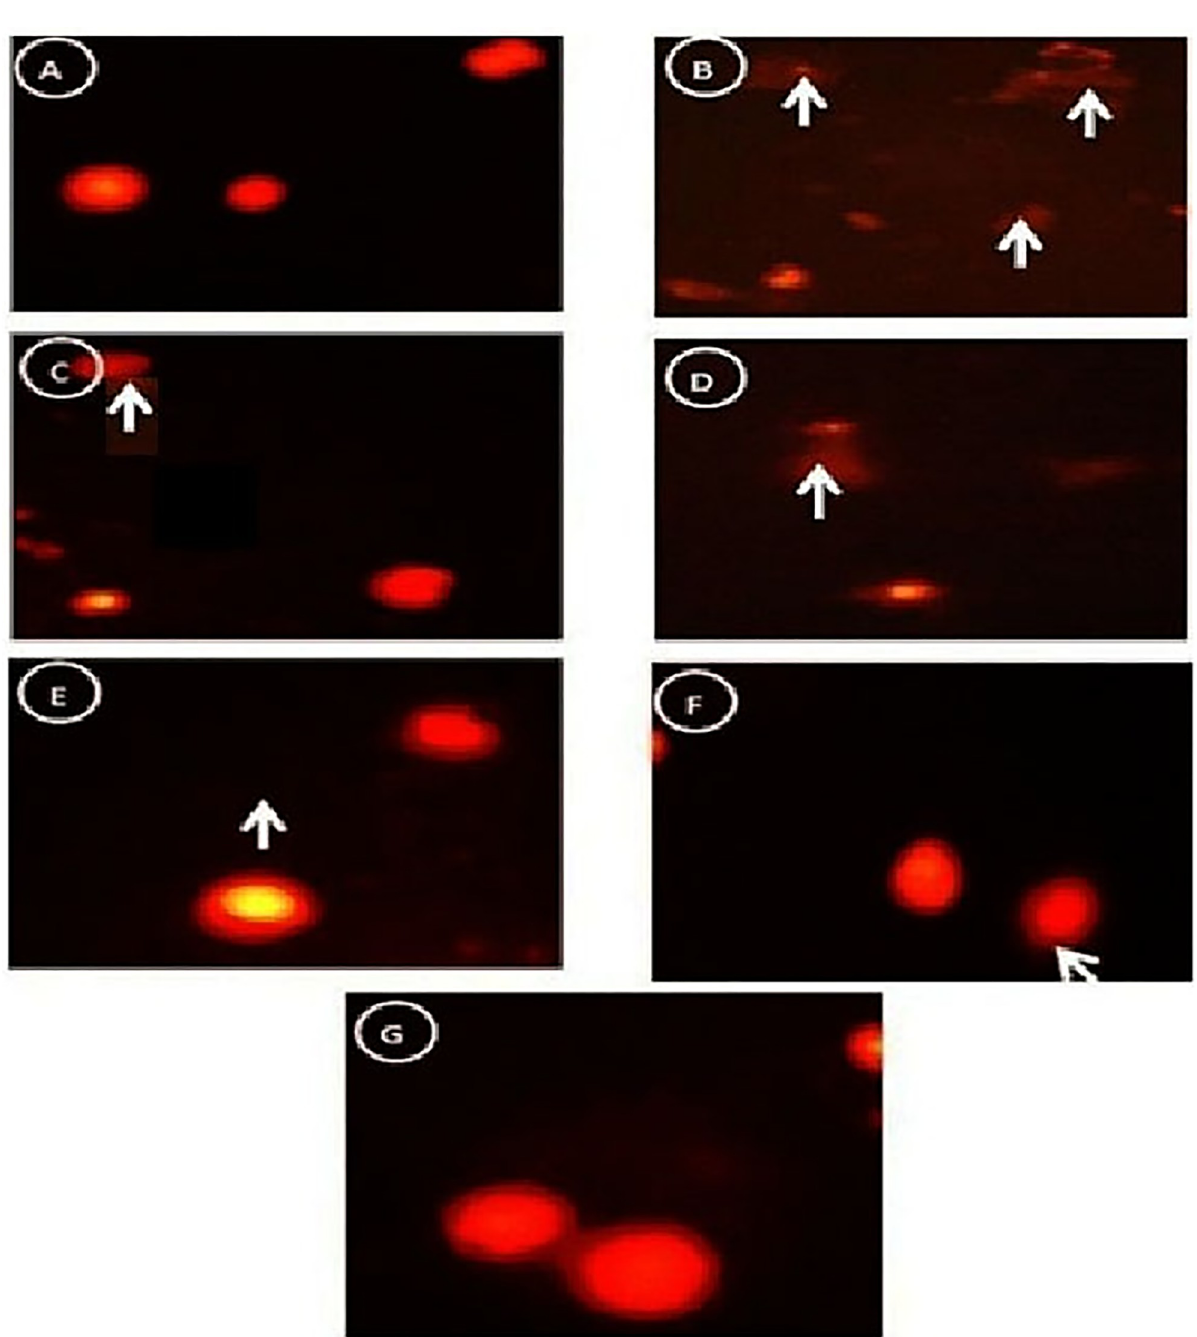
Fig 15. (A) Control group showed normal round cells with intact nuclei. (B) STZ group showed greater damage, as evidenced by the presence of more than two apoptotic cells with the appearance of a large hollow area near the tail and a small head (comet). (C) STZ + stem cells group showed some intact nuclei and some apoptotic cells. (D) STZ + Q group showed lower DNA damage, as evidenced by fewer damaged nuclei and with a hollow area (tail). (E) STZ + Q/Zn group showed lower DNA damage and fewer damaged nuclei. (F) STZ + Q and stem cells group showed higher amelioration and lower DNA damage. (G) STZ + Q/Zn and stem cells group showed more intact cells and fewer comet cells and undamaged DNA.